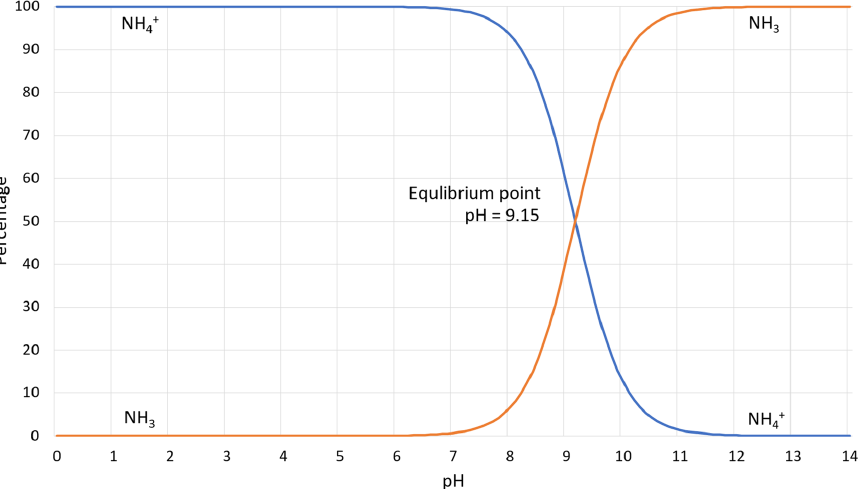
Figure 3. Dependence of percentages of free ammonia ( 𝑁𝐻 (cid:2871) ) and ionized ammonia (ammonium ( 𝑁𝐻 (cid:2872)(cid:2878) )), abundance, and pH at T = 25 °C